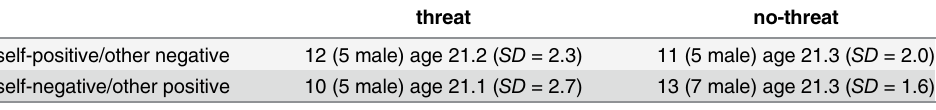
Table 1. Demographics of the threat vs. no-threat group who evaluated either self-positive/other-neg- ative or self-negative/other positive